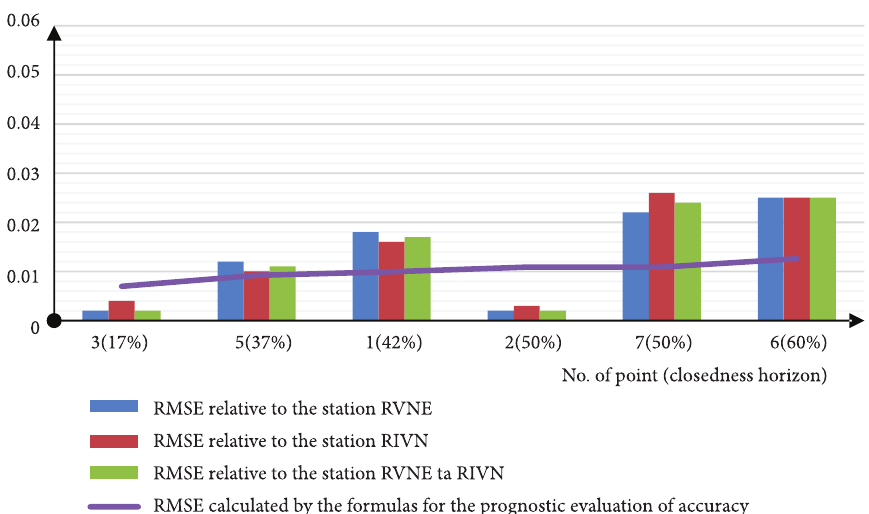
Figure 4. Comparison of RMSE of the planned location by the session duration for 1 hour with executing the preliminary planning and prognostic points of accuracy evaluation calculated by Equation (5)